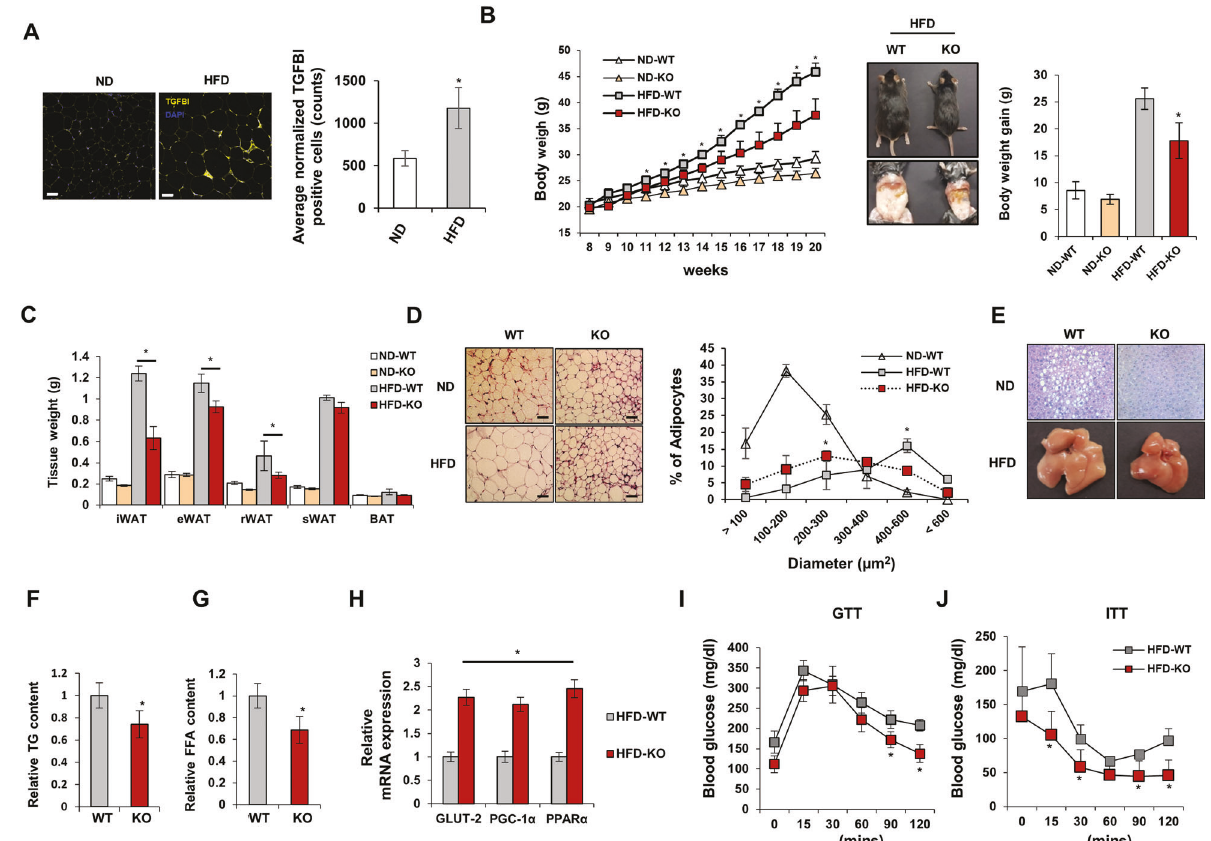
Fig. 1 TGFBI-de fi cient mice are resistant to high-fat diet-induced obesity. A TGFBI was stained in iWAT from ND-fed or HFD-fed mice and quanti fi ed (right). Scale bar, 40 µm. B WT and KO mice (8 weeks old) were fed a high-fat diet (HFD) or normal diet (ND) for 12 weeks, and body weight was recorded every week (left). On the fi nal day of the experiment, representative photos were taken of the HFD-fed WT and KO mice (middle). The gain in body weight was calculated using the following formula: fi nal weight (20 weeks old) – initial weight (8 weeks old). C Indicated organ weights from the above mice. D Representative H&E staining of iWAT obtained from the ND- or HFD-fed WT and KO mice. Scale bar, 50 µm. (left). Diameter distribution of adipocytes in the indicated adipose tissues (right). E Representative H&E staining of livers from the 20-week-old HFD-fed WT and KO mice. The bottom panel shows representative livers from the above mice. F-G TG and FFA content from the HFD-fed WT and KO mice. H Relative mRNA expression of the indicated genes in the livers of the HFD-fed WT and KO mice. I-J GTT and ITT results. Error bars represent the ± SEM. * p < 0.05 by two-sided t